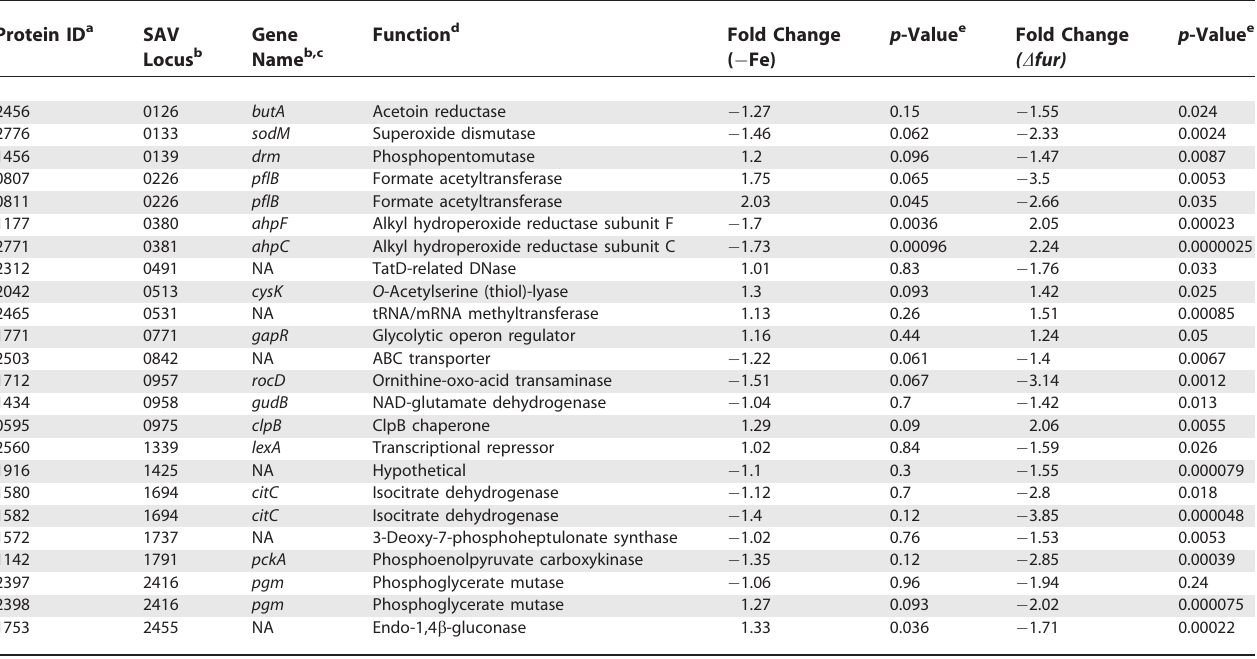
a Protein ID corresponds to Master Number in the Master Table S1. b SAV number corresponds to position in the annotated S. aureus Mu50 genome. c Gene name corresponds to name listed in annotation of Mu50 genome. NA signifies no gene name listed. d Gene name and function were determined based on closest hit in a BLAST search with an e value of less than 10 (cid:1) 10 . e p -Values were calculated using the Student’s t -test. DOI: 10.1371/journal.ppat.0020087.t005 PLoS Pathogens |